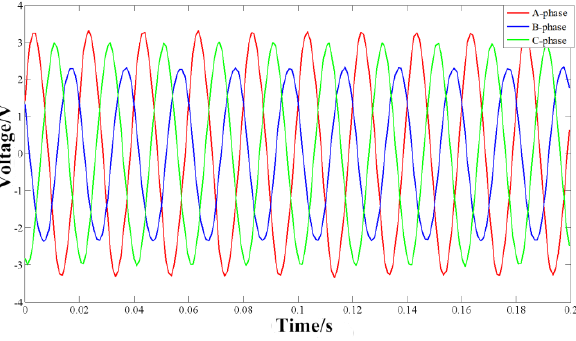
Figure 7. Three-phase current waveform of the fault motor.